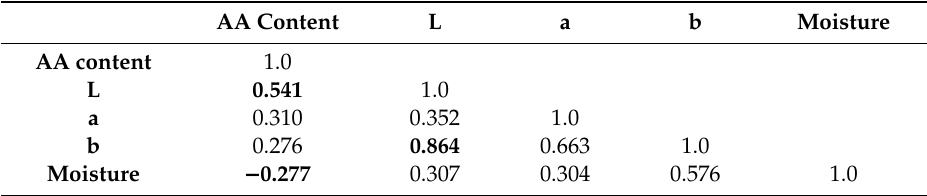
Table 3. Correlation matrix between the acrylamide content and the colour and moisture of biscuits (Biscuit D). In bold, significant values (except diagonal) at the level of significance 95%.